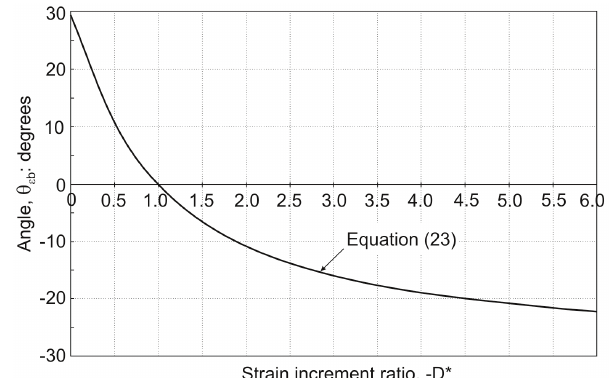
Fig. 1. Relationship between   b and D *